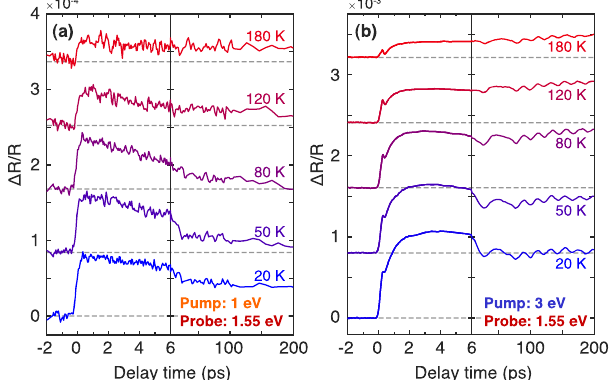
Fig. 2 Photoinduced time-resolved changes in re fl ectivity ( Δ R / R ) in α - Sr 2 CrO 4 . We measured Δ R / R at 1.55 eV after ( a ) 1.0 eV and ( b ) 3.1 eV photoexcitation at various temperatures.